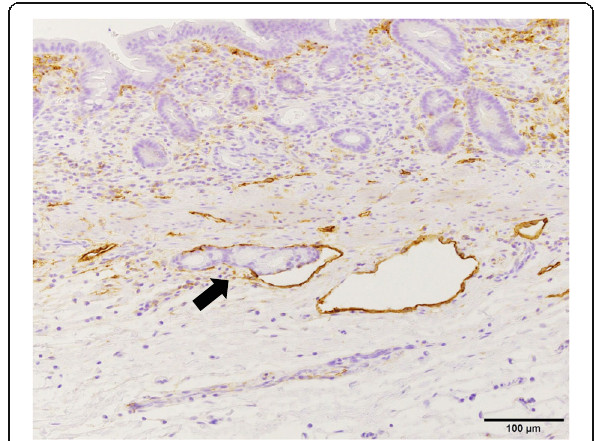
Fig. 6 Pathological findings in the additional examined sample showing lymphatic invasion below the muscularis mucosa with D2- 40 staining; original magnification ×